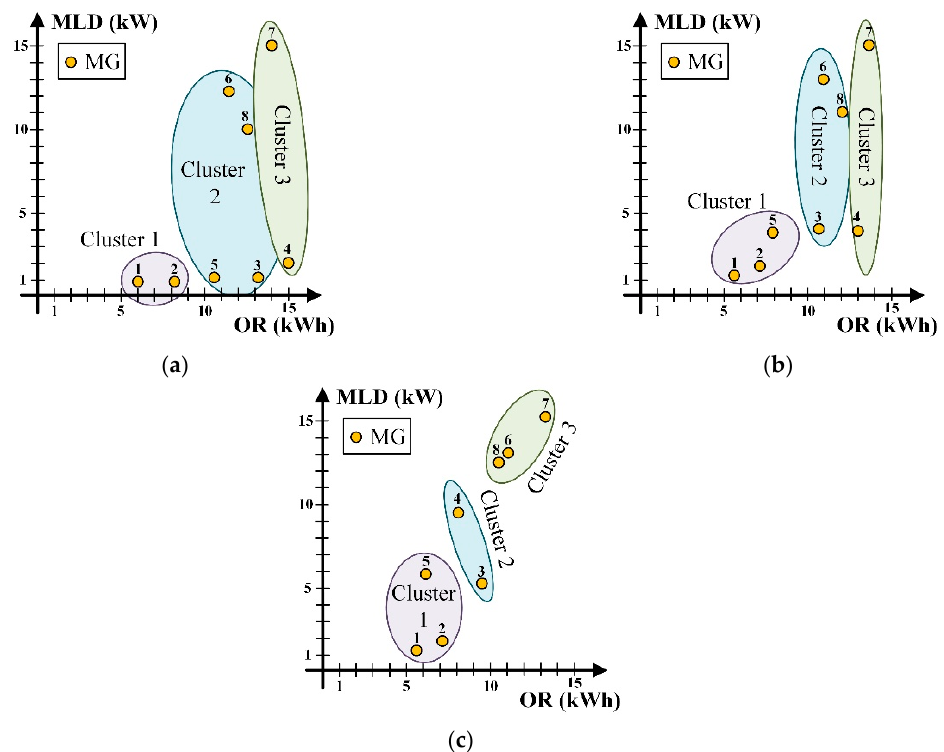
Figure 6. K-means and SOM clustering for time steps 1, 8, and 16. ( a ) Time step 1, ( b ) Time step 8, ( c ) Time step 16. Table 3. K-means and SOM clustering results.